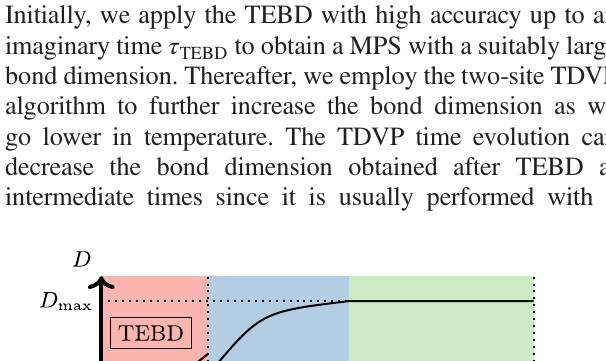
FIG. 10. Accuracy of imaginary-time evolution. We compare the overlap defect Δ for different choices of the TDVP cutoff ε and time step τ . We investigate temperatures T=t ¼ 0 . 50 ( β = 2 ¼ 1 ) in (a),(b), T=t ¼ 0 . 10 ( β = 2 ¼ 5 ) in (c),(d), and T=t ¼ 0 . 02 ( β = 2 ¼ 25 ) in (e),(f). The left (resp. right) panels show time FIG. 9. Sketch of the MPS time-evolution strategy and bond evolutions of the state j σ p i (resp. j σ p i ), where we choose dimension D as a function of the imaginary time τ . An initial ¼ 0 ¼ 1 = 6 U=t ¼ 10 . The defect is directly related to the cutoff ε . A choice TEBD up to τ is followed by a two-site TDVP evolution. TEBD of τ ¼ 0 . 5 is optimal in most circumstances. The accuracy does Once the MPS reaches a maximum bond dimension D , we max not appear to deteriorate at lower apply the single-site TDVP algorithm until time β = 2